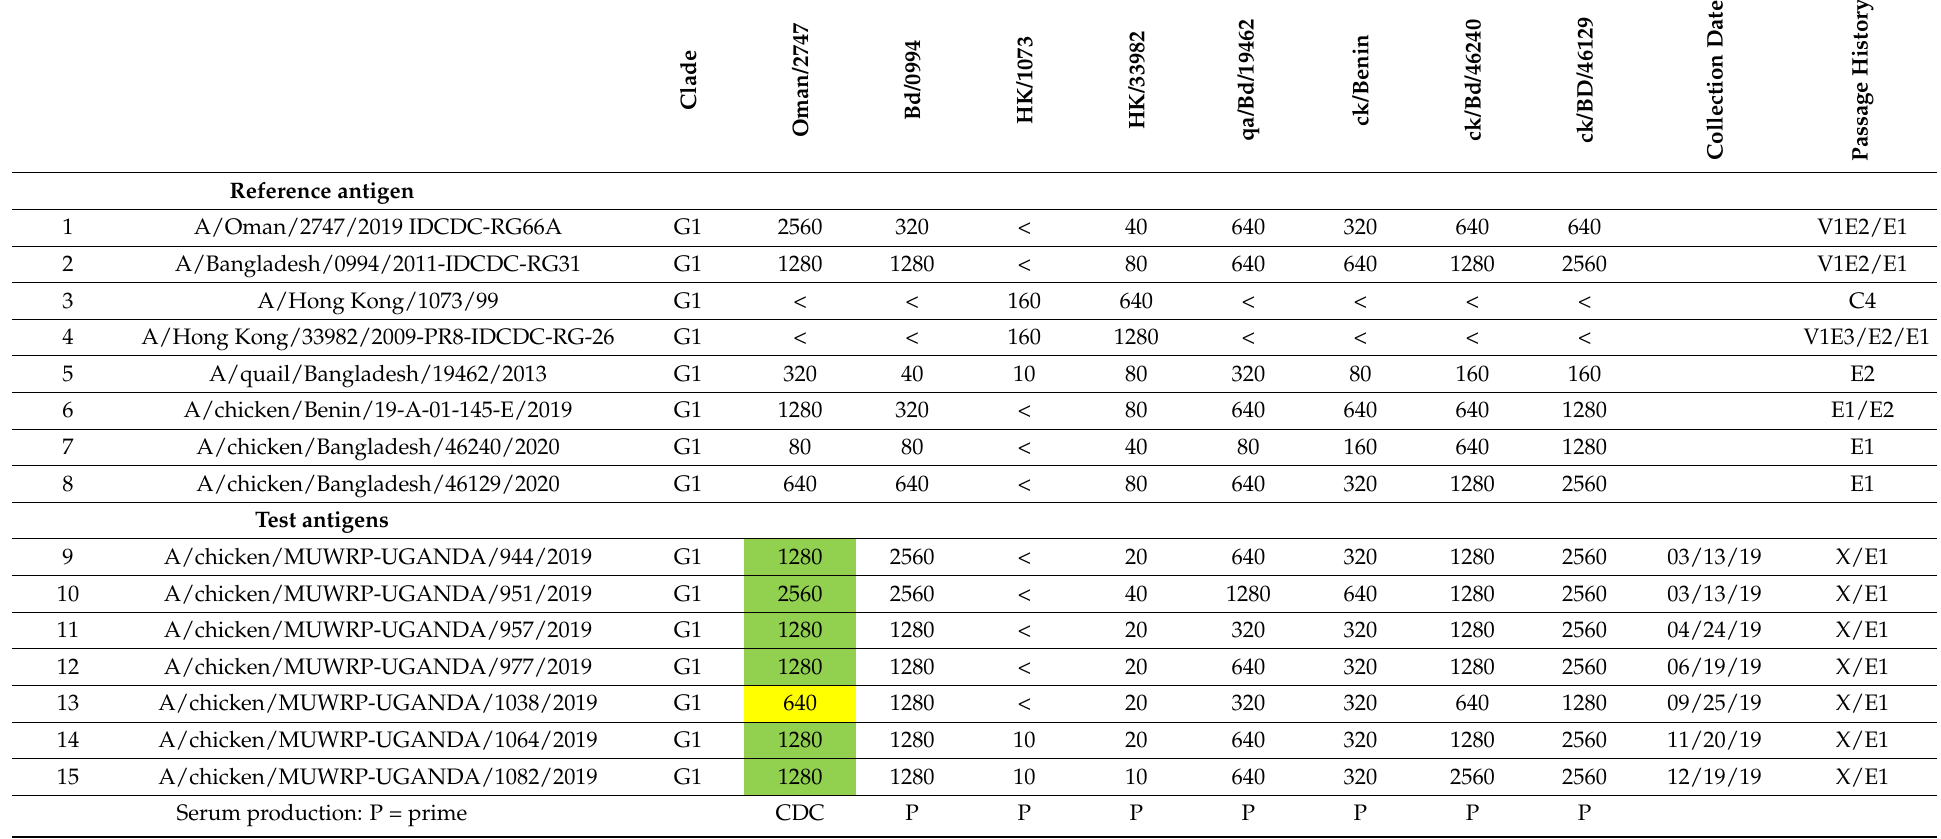
Table 2. Hemagglutination inhibition assay of recent H9N2 viruses from Uganda (0.5% turkey RBC).